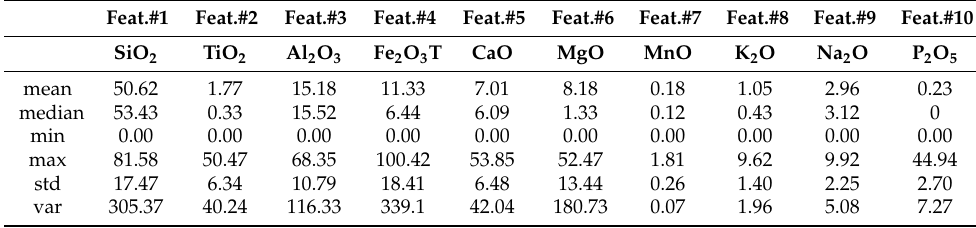
Table 3. Basic statistics of Dataset 1.